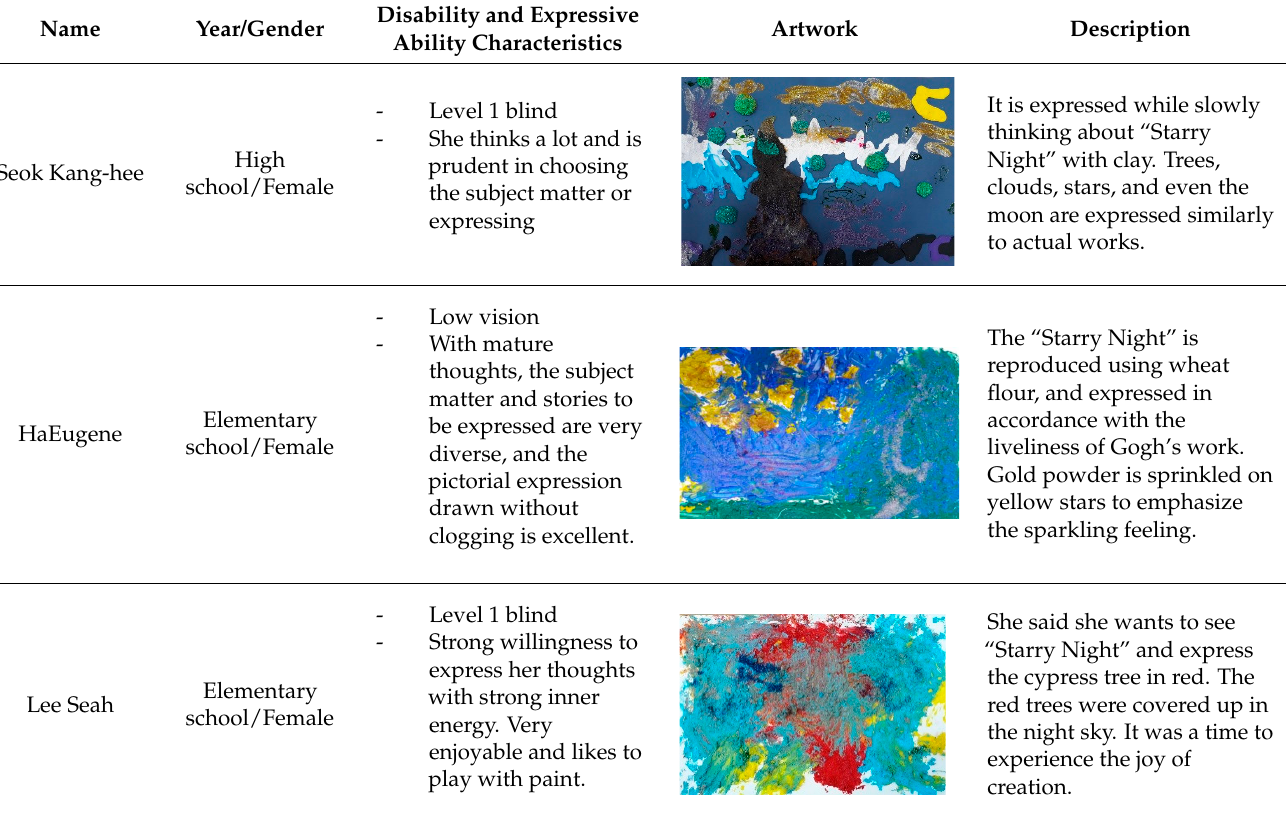
Table 3. Students’ works that reflects personal impressions of the BlindTouch exhibit [36].